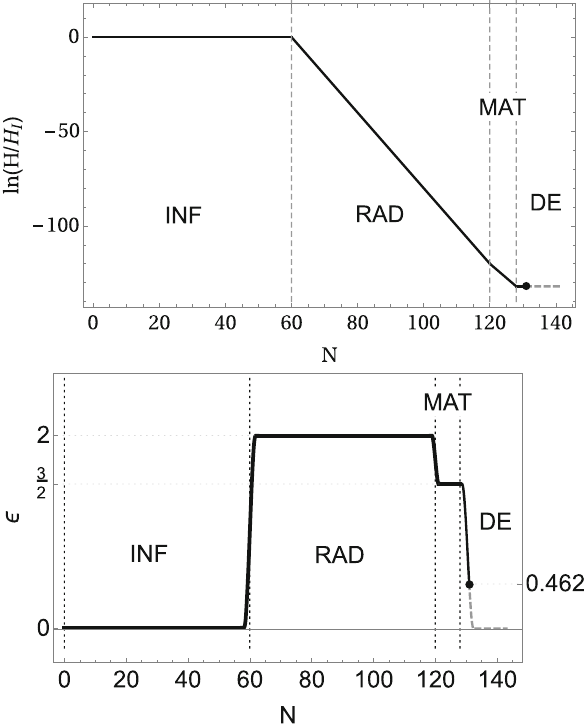
Fig. 1 Schematic evolution of the Hubble parameter (left), and the (cid:12) parameter (right) during the history of the Universe. The dot on the curves designates where we are today